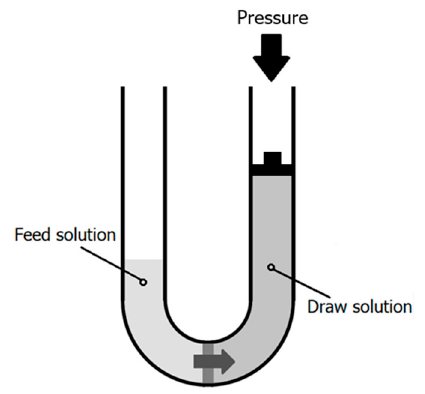
Figure 5. PRO working principle.